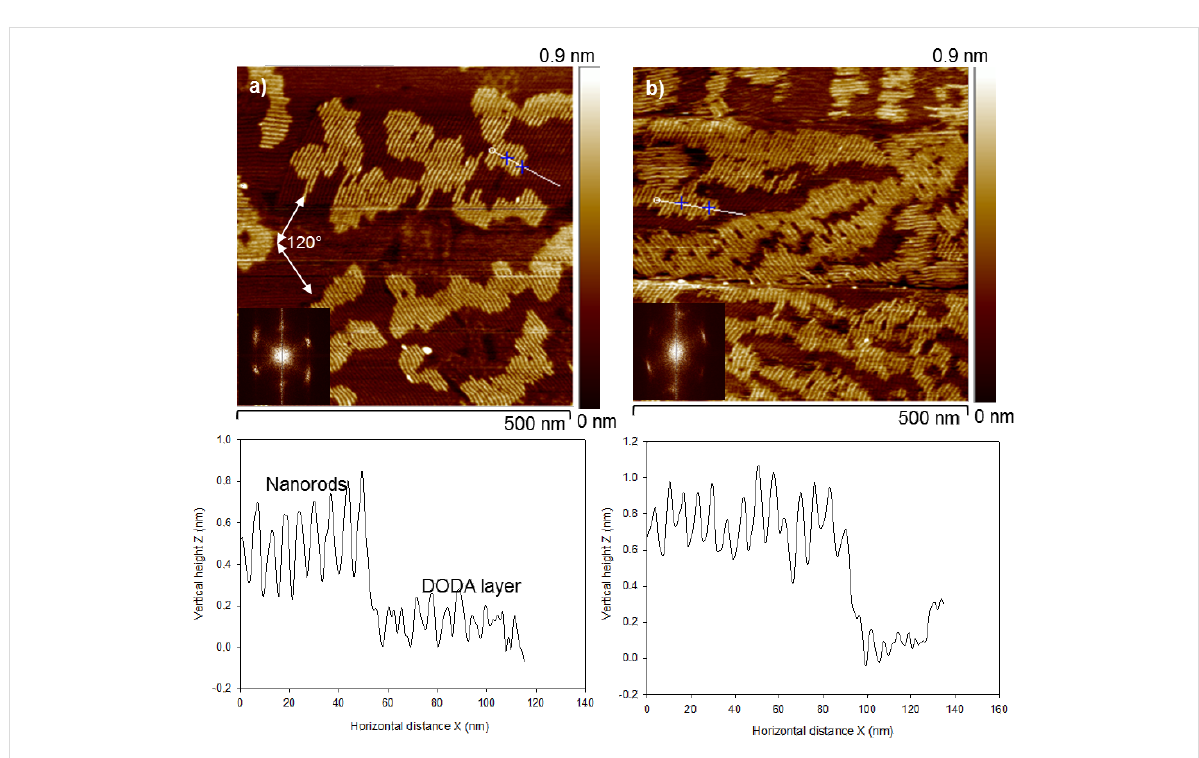
Figure 4: TM-AFM images of the different DODA–POM hybrids deposited on HOPG. a) Hybrids made from Keggin POM, b) Hybrid made from WD-POM. Insets show 2DFFT images. Cross-section analyses taken along the white lines are shown below each